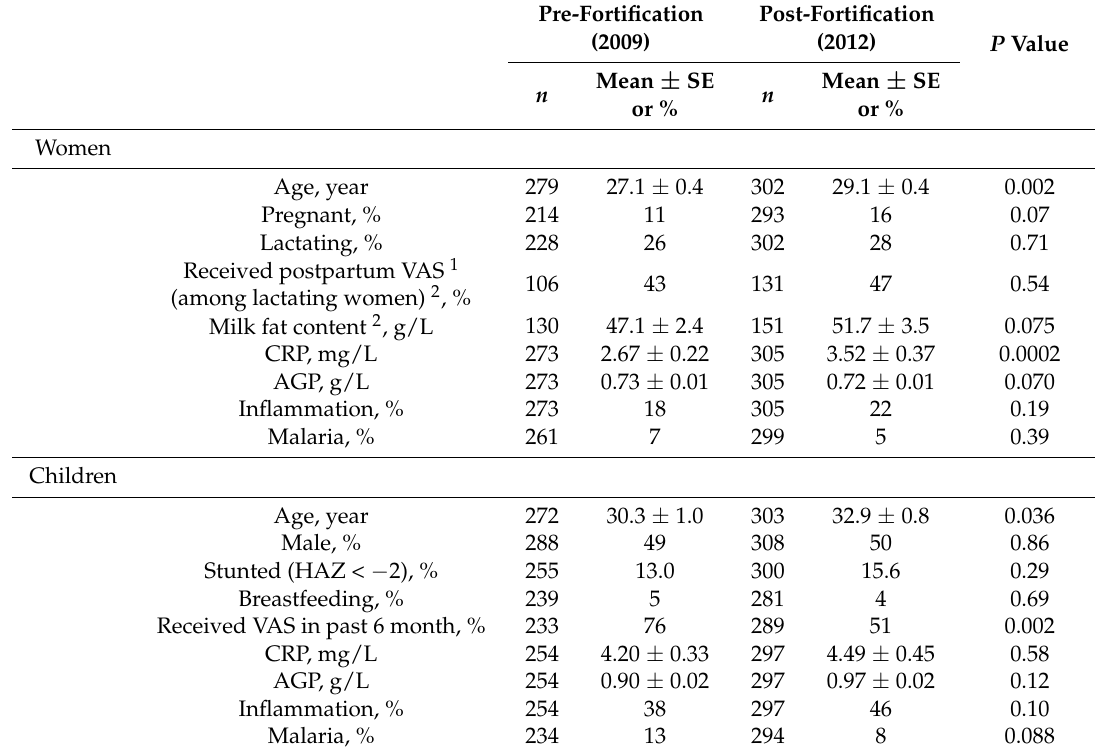
Table 1. Characteristics of women and children in Yaound é and Douala, Cameroon who participated in the baseline and post-fortification